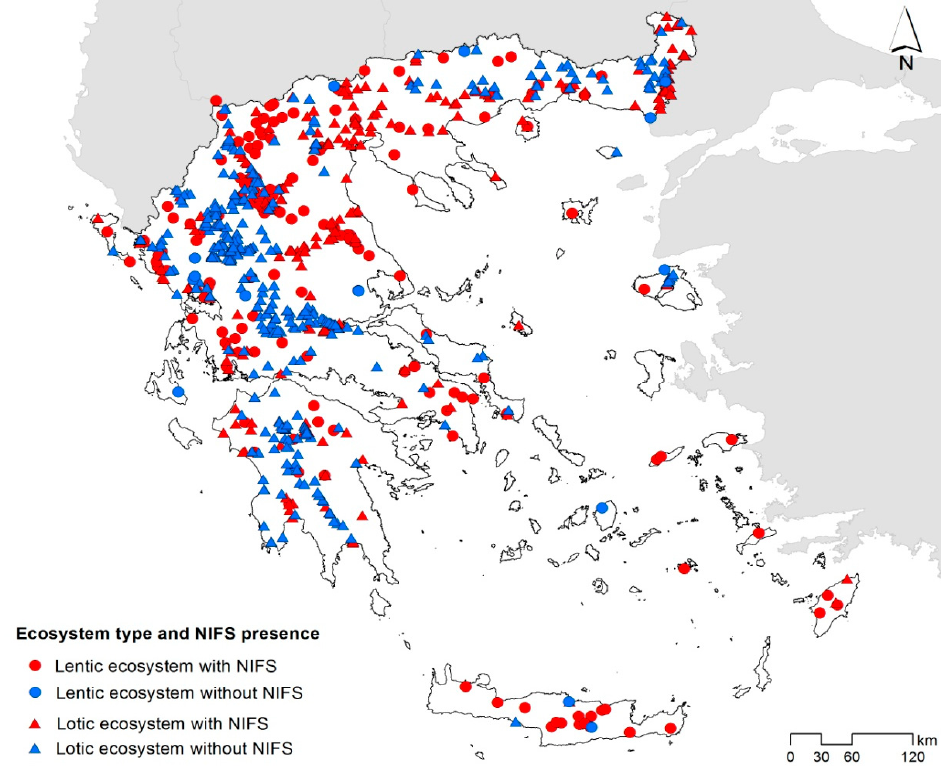
Figure 1. Map of Greece indicating the location of lentic (points) and lotic (triangles) ecosystems used in this study. Red symbols indicate locations occupied with NIFS and blue NIFS-free loca- tions.